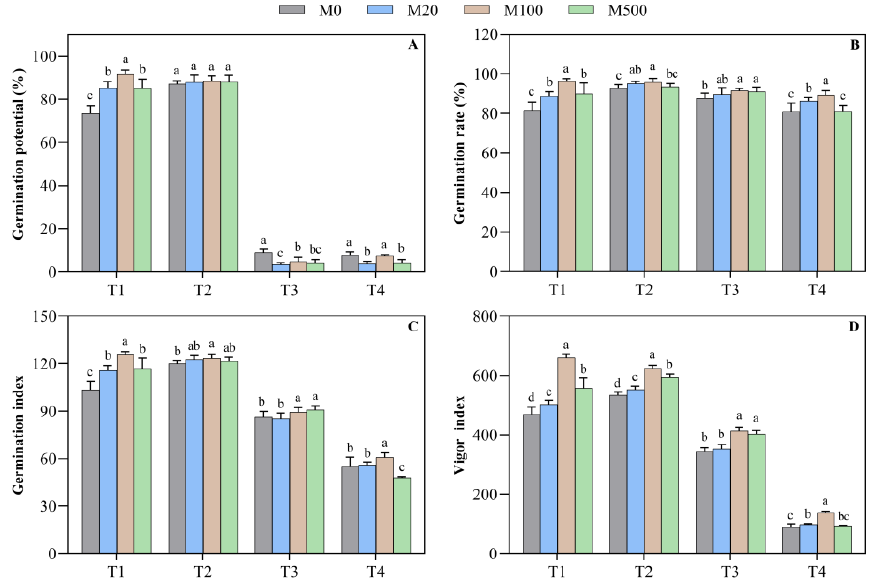
Figure 1. Effects of exogenous melatonin on the germination characteristics of rice seeds under high temperature stress. Means ± SEs with different letters in each parameter indicate significant statistical differences ( p < 0.05). ( A ) Germination potential; ( B ) germination rate; ( C ) germination index; and ( D ) vigor index.